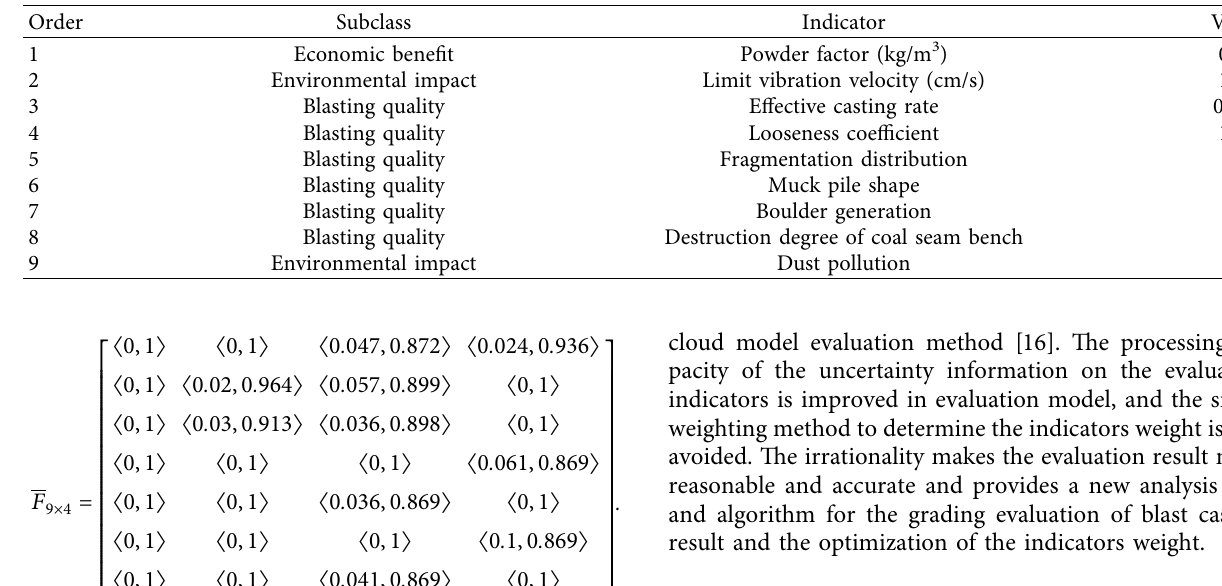
Table 4: Evaluation indicator of the blast casting